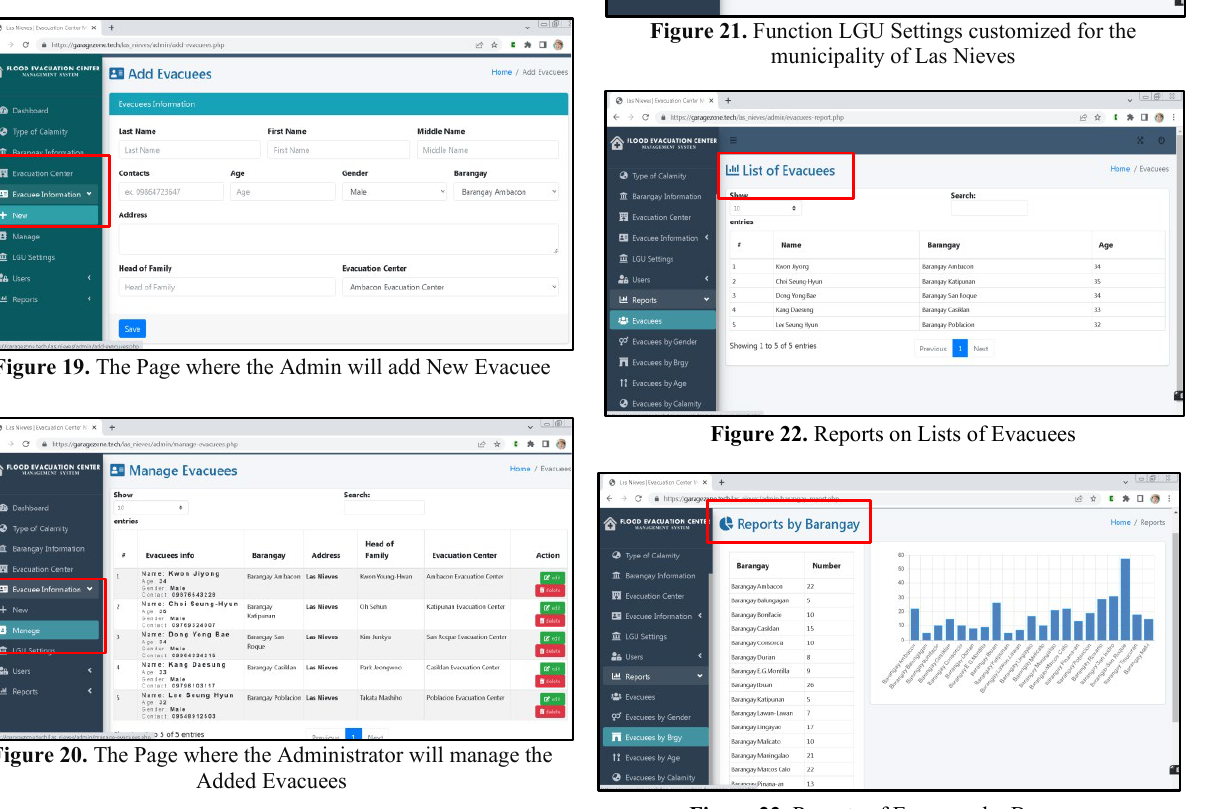
Figure 23. Reports of Evacuees by